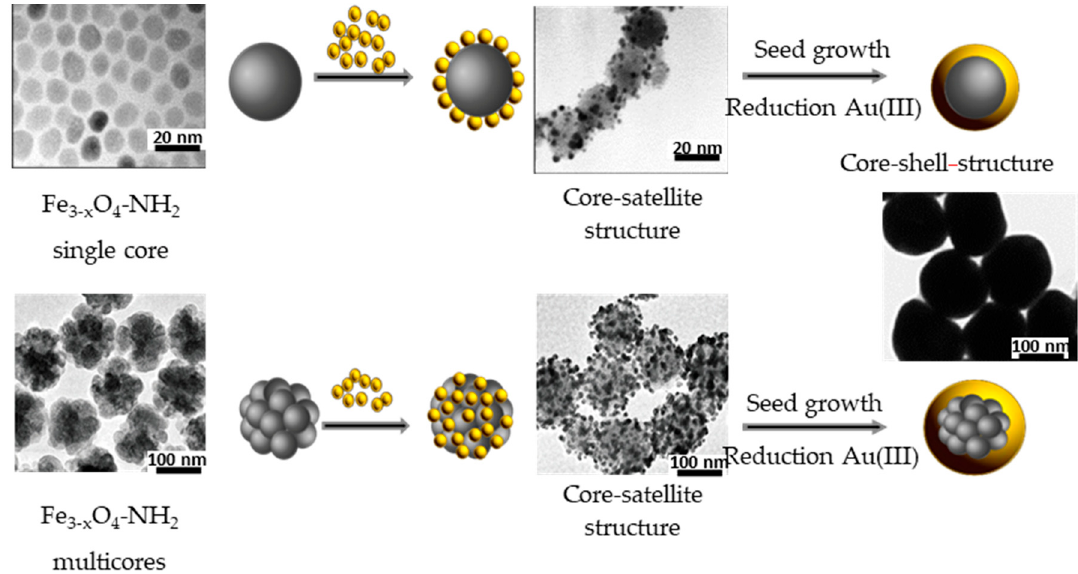
Figure 2. Schematic overview of the formation of core-satellite (top: reproduced with permission from [46]. American Chemical Society, 2005, and bottom: reproduced with permission from [47]. Royal Society of Chemistry, 2015). representative transmission electron microscopy (TEM) images) and core-shell spherical structure (representative TEM image reproduced with permission from [48], American Chemical Society, 2016).